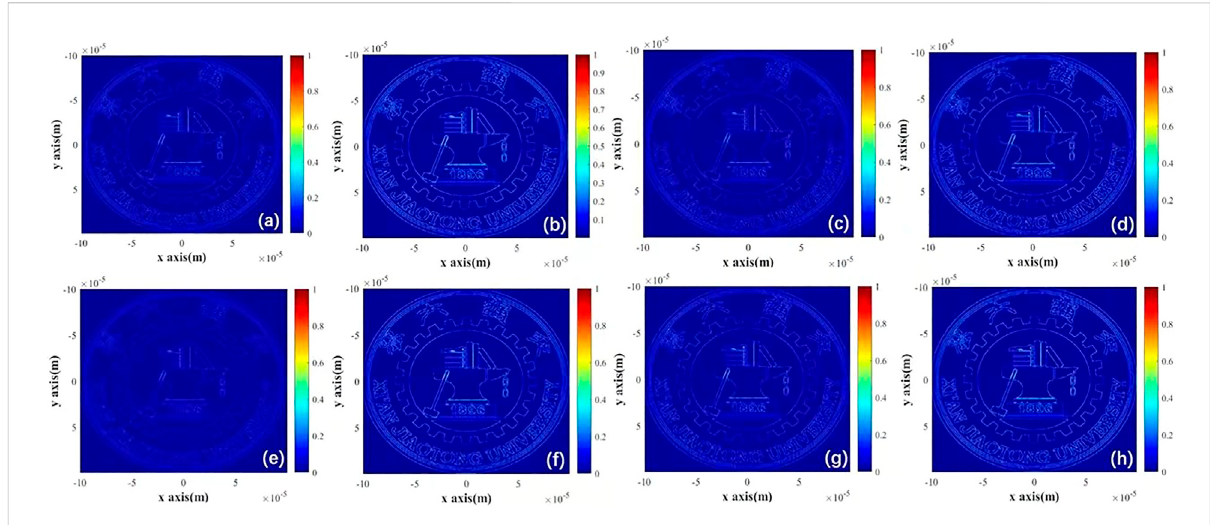
FIGURE 7 Spatial differentiation effect based on materials with different index